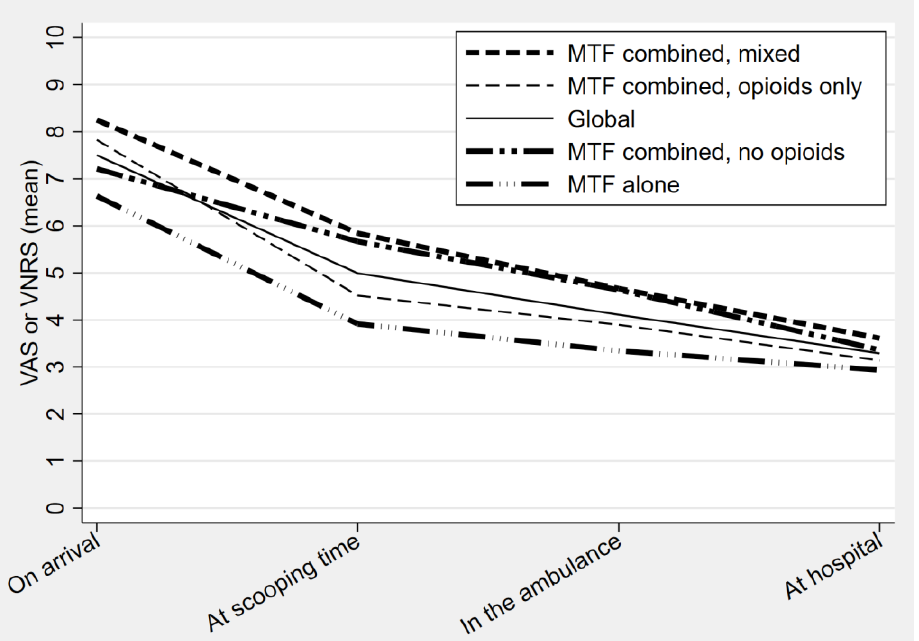
Figure 2. Evolution of the pain over the time (by group of treatment).